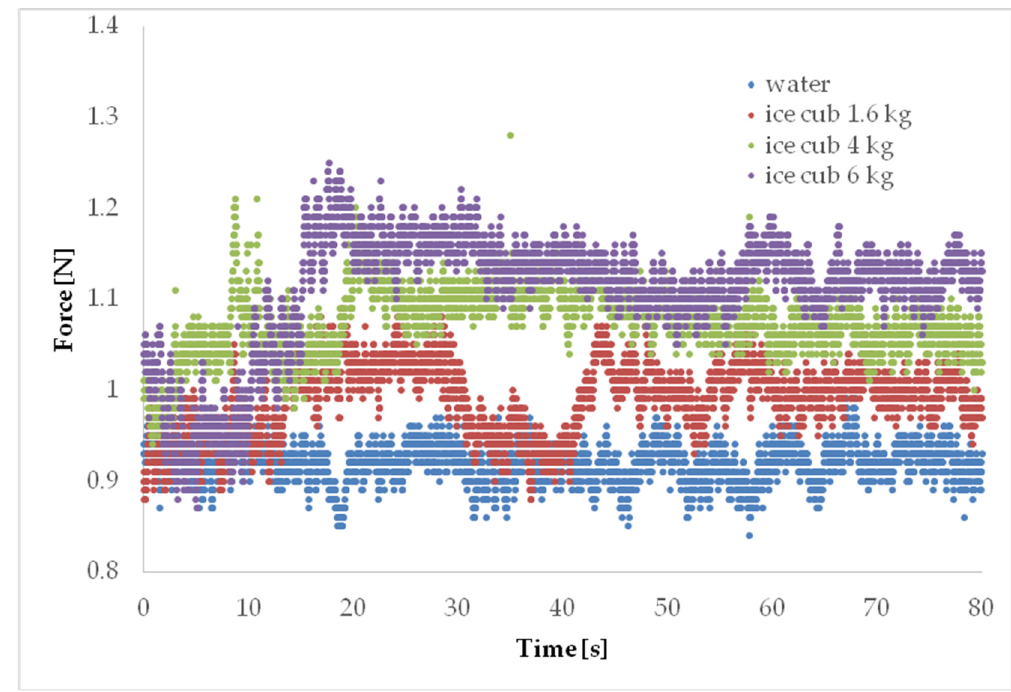
Figure 4. Changes in drag forces over time for different doses of ice.